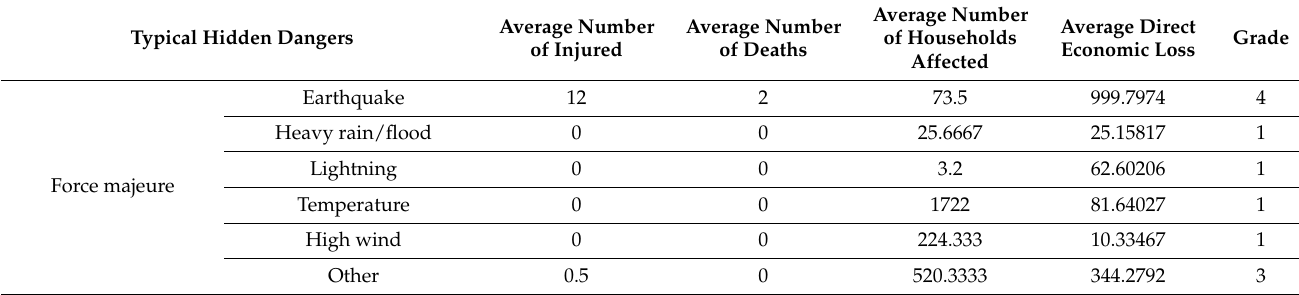
Table 8. Typical hidden danger accident loss